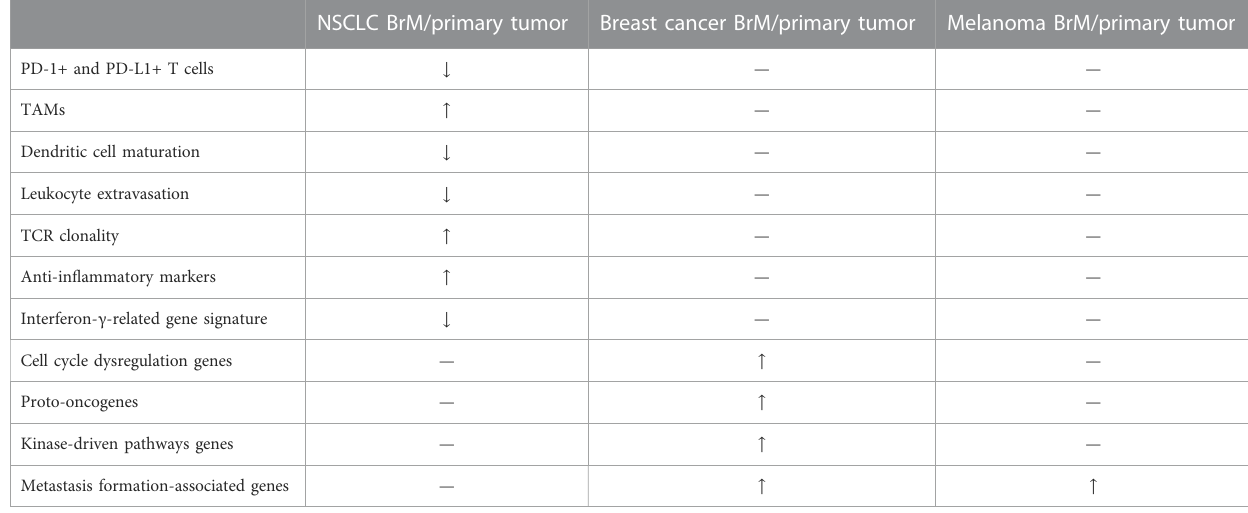
TABLE 3 Comparison between BrMs and primary tumors. Anti-in fl ammatory markers include TOLLIP, HLA-G. Cell cycle dysregulation genes include E2F3 and RB. Proto-oncogenes stand for KRAS and ALK. Kinase-driven pathways represent SRC, mTOR and HER2. Metastasis formation-associated genes include CXCR4, PLLP, TNFSF4, VCAM1, SLC8A2, and SLC7A11. BrM/primary tumor represents relative relationship between BrM and primary tumor. TAMs, tumor-associated macrophages. NSCLC, non-small cell lung